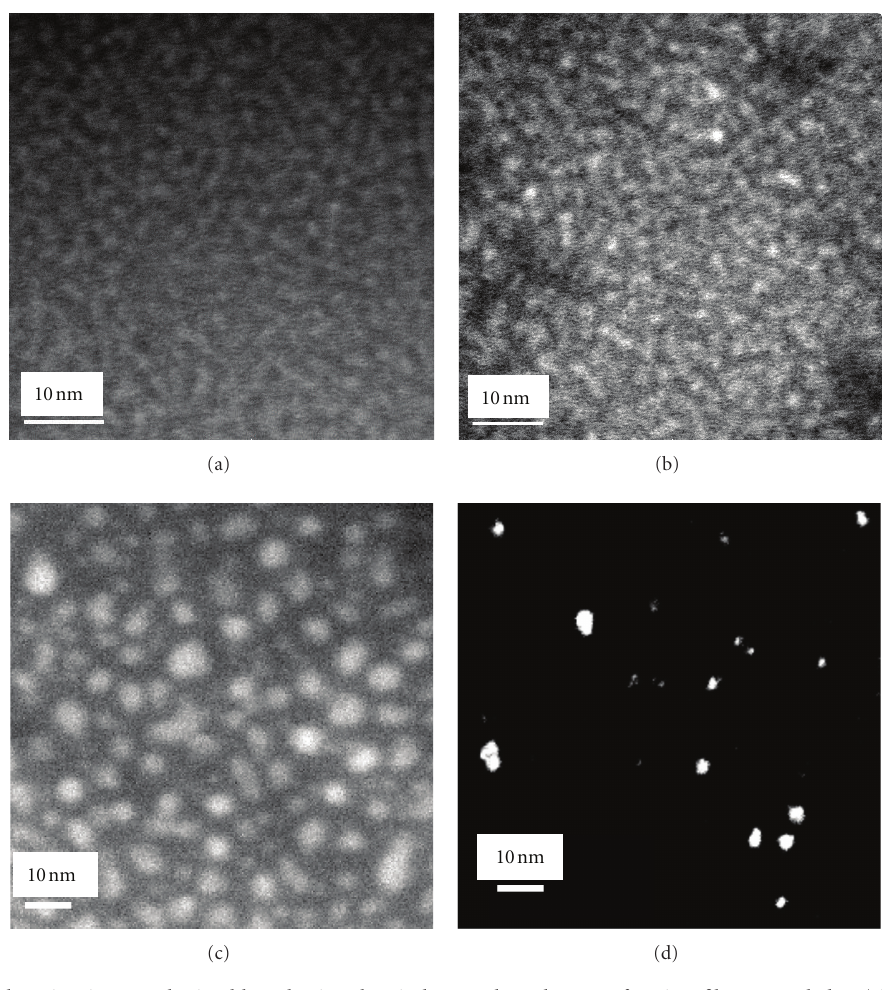
Figure 4: EFTEM plan view images obtained by selecting the Si plasmon loss electrons for SiO x films annealed at (a) 900 ◦ C, (b) 1000 ◦ C, and (c) 1250 ◦ C. (d) DFTEM plan view image obtained from a SiO x film annealed at 1250 ◦ C.